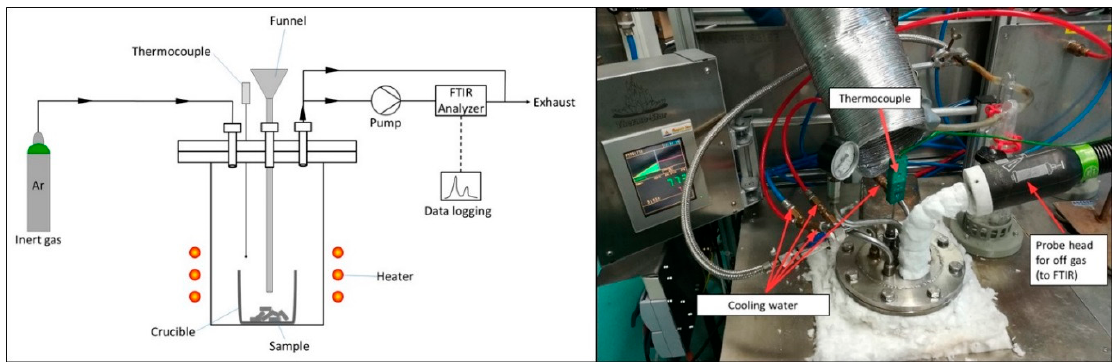
Figure 2. Schematic figure ( left ) and photo ( right ) of the experimental setup.